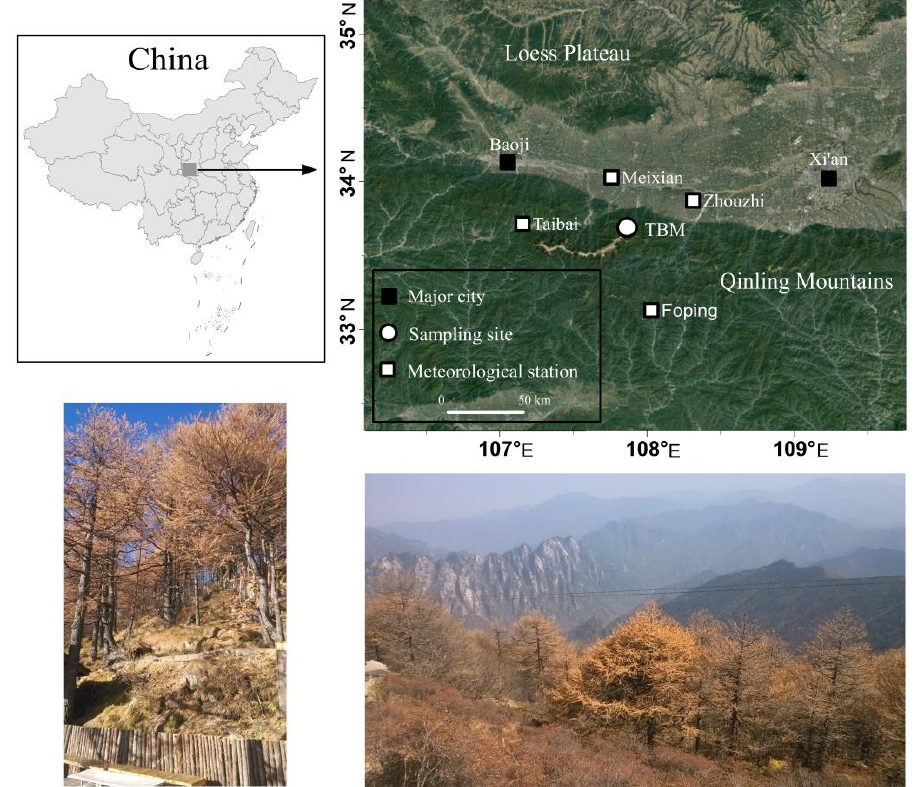
Figure 1. Location of the sampling site and surrounding meteorological stations. Black squares represent cities, white circles represent sampling sites, and white squares represent meteorological stations. Google © is the source of satellite image.